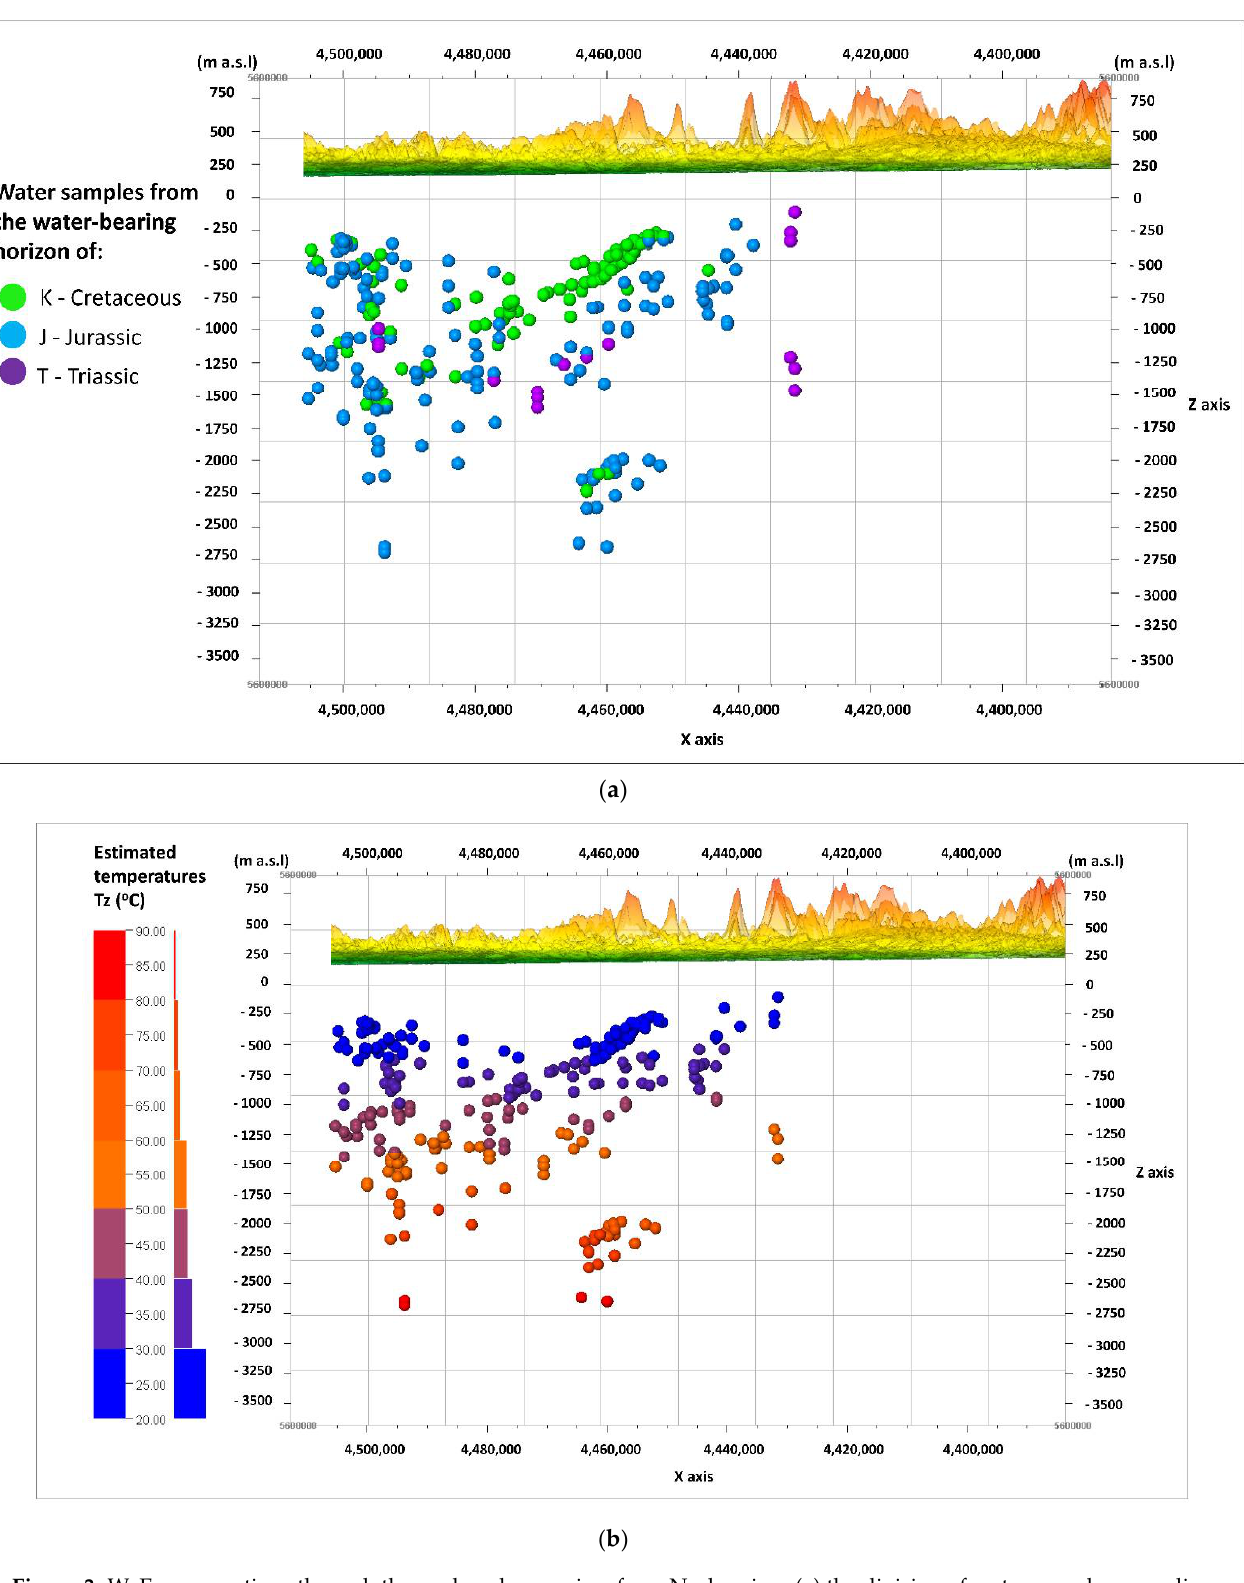
Figure 3. W–E cross-sections through the analyzed area; view from N, showing: ( a ) the division of water samples according to their origin from the Cretaceous (K), Jurassic (J), or Triassic (T) aquifers; ( b ) the distribution of the estimated depth temperatures (Tz).